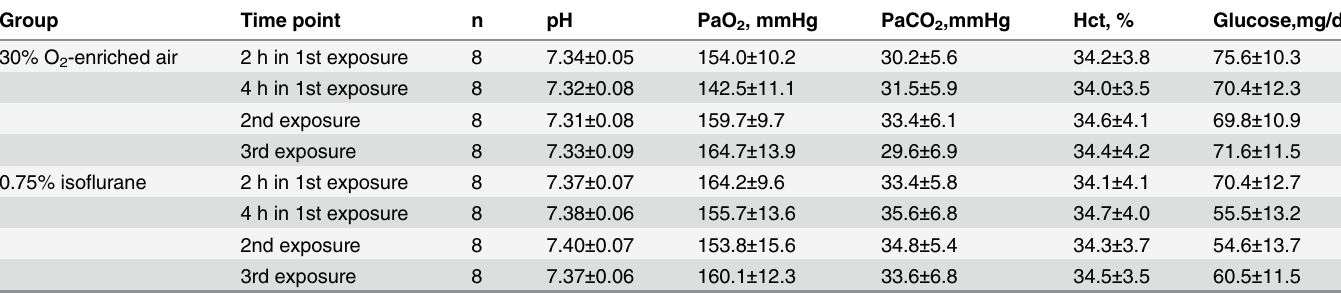
Table 1. Blood Gas and Blood Glucose Analyses during Gas Exposure.